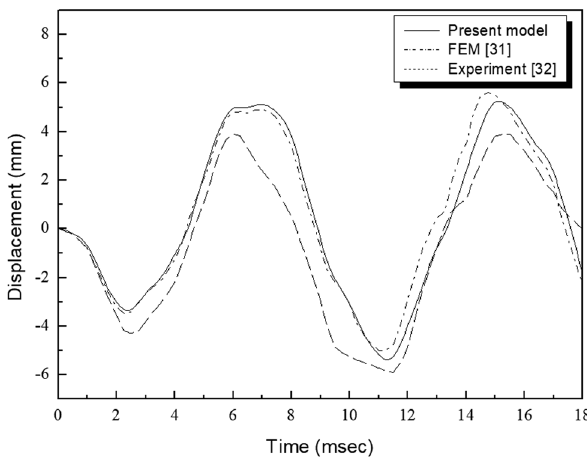
Figure 5: Displacement - time response of the center of the square plate subjected to air blast.